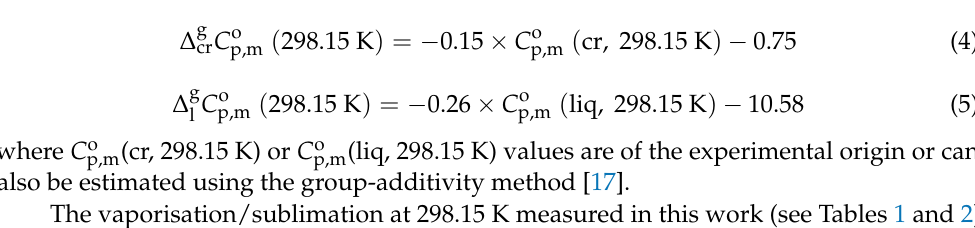
H o m for the benzophenone cr,l